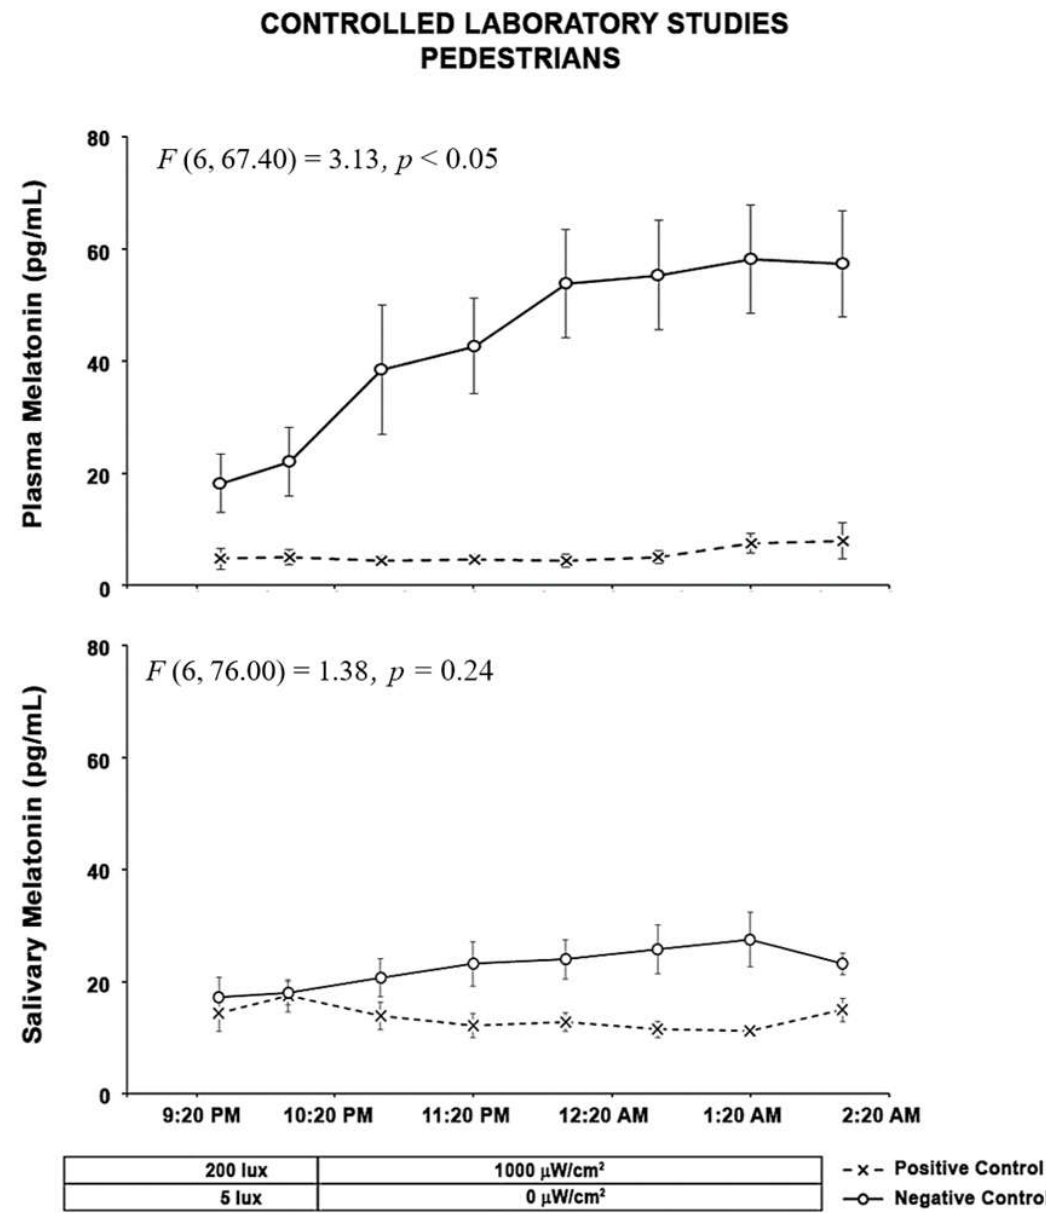
Figure 3. The two graphs above show results from subjects in the positive and negative control studies. The “O” symbols represent the mean (± standard error of the mean, SEM) plasma and salivary melatonin levels during the negative control study when subjects were exposed to darkness from 10:00 PM to 2:00 AM The “X” symbols represent the mean (±SEM) plasma and salivary melatonin levels during exposure to 1000 µW/cm 2 (2132 lx Melanopic EDI) electric light from 10:00 PM to 2:00 AM Statistical comparisons of melatonin values are for the exposure periods only (10:00 PM to 2:00 AM) and are based on the linear mixed model (LMM). For plasma melatonin suppression, the results showed that the main effects of the type of test (F (1, 13.3) = 74.9, p < 0.0001) and time (F (6,68.2) = 11.75, p < 0.0001) were significant and the interaction between type of test and time was also significant ((F (6 ,67.4) = 3.13, p = 0.0091). For the salivary melatonin suppression, the main effect of the type of test was significant (F (1, 21.1) = 23.32, p < 0.0001).